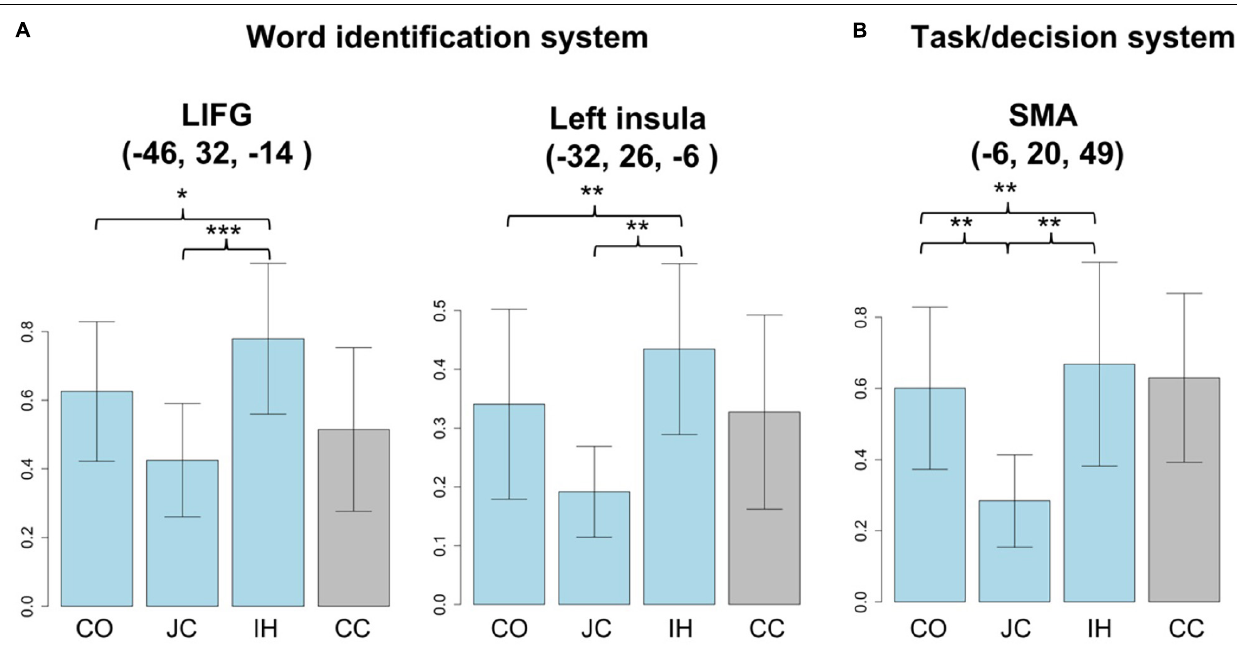
FIGURE 4 | Activation patterns associated with the response to each word type. The x -axis indicates the word types (CO, cognate; JC, Japanese control word; IH, interlingual homograph; CC, Chinese control word). The y -axis indicates the mean activation level during the response to each word type. The response to pseudowords (PWs) was treated as the baseline. (A) A significant difference was observed between the responses to IHs and JCs in the word identification system, LIFG (left inferior frontal gyrus) and left insular. (B) In the task/decision system, SMA (supplementary motor area), a significant difference was observed not only between the responses to IHs and JCs but also between those to COs and JCs (* p < 0.05, ** p < 0.01, *** p <